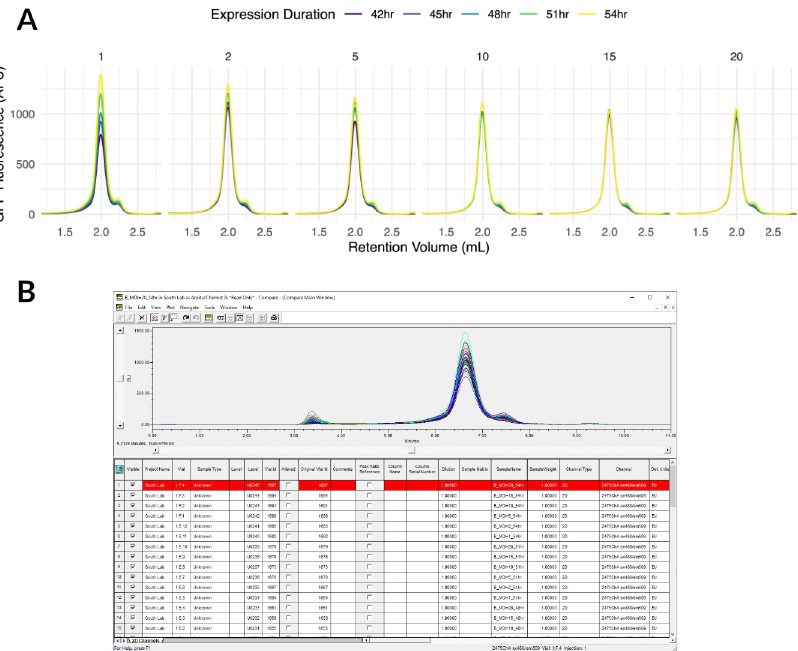
Fig 4. Comparison of Appia and manufacturer software. Small cell pellets with the indicated baculovirus MOI and expression duration were thawed, solubilized in DDM, and run in a Waters Acquity Arc Bio HPLC over a Superose 6 Increase 5/150 column. A: Data processed and visualized with Appia and ggplot. Data export and visualization took approximately 20 seconds. Trends in both expression duration and MOI are obvious, and the user can move on with larger-scale expression tests. B: The same data as viewed in the manufacturer